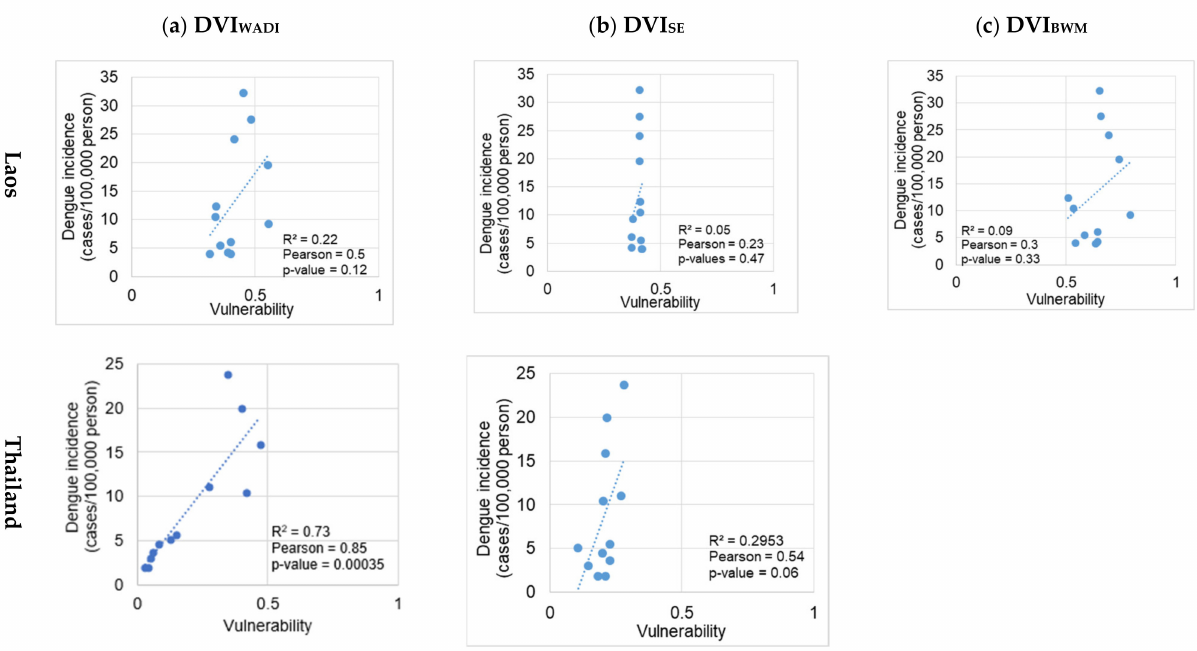
Figure 4. Scatter plot of average monthly dengue vulnerability indices and dengue incidence rate per 100,000 persons and ( a ) Dengue Vulnerability Index–Water Associated Disease Index (DVI WADI ) and ( b ) Dengue Vulnerability Index– Shannon’s Entropy (DVI SE ), ( c ) Dengue Vulnerability Index–Best-Worst Method (DVI BWM ), in Laos (first row) and Thailand (second